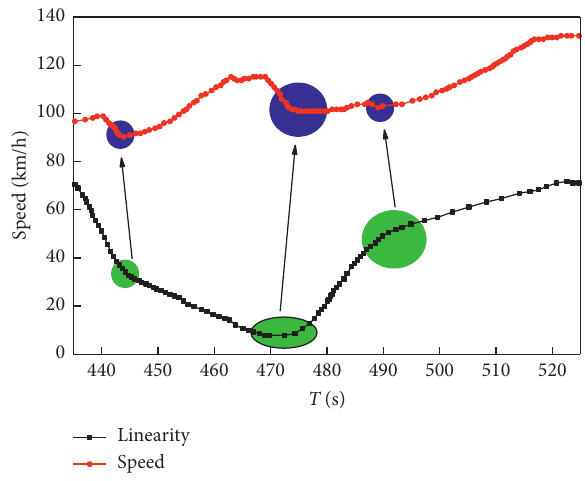
Figure 1: Relationship of speed and